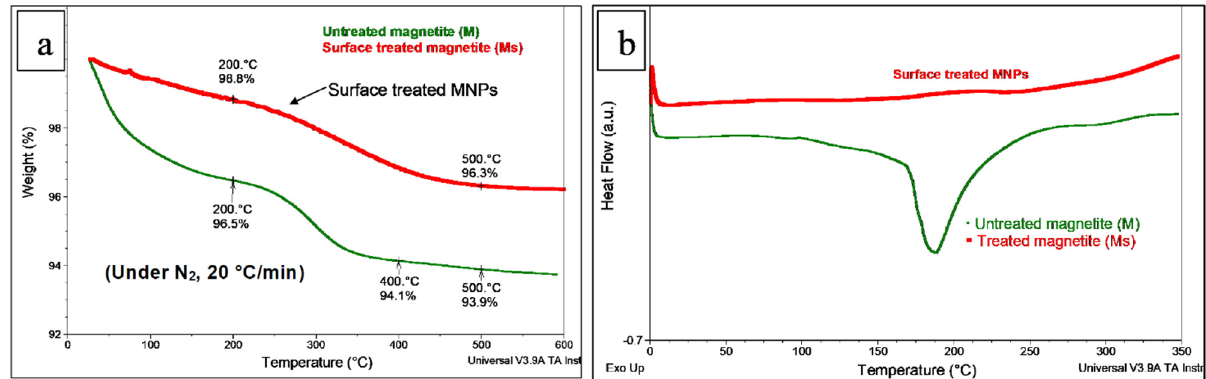
Figure 2. ( a , b ) Comparative ( a ) TG and ( b ) DSC curves of treated (Ms) and untreated (M) magnetite NPs.